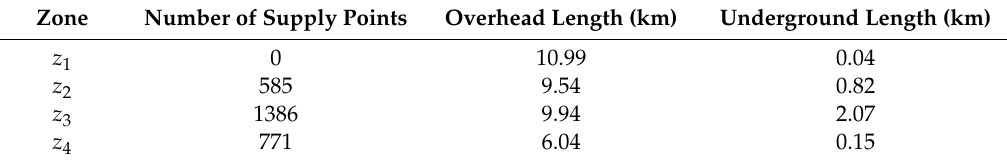
Table 4. Network Table 4. Network characteristics.